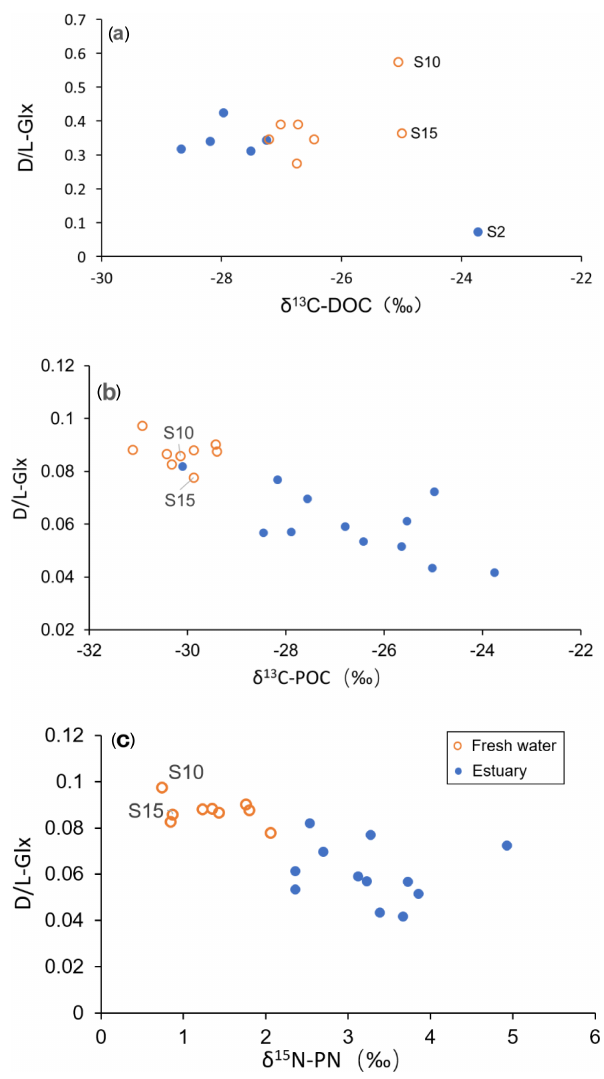
Figure 6. D / L ratio of AAs (as Glx) plotted against (a) DOC- δ 13 C (b) POC- δ 13 C, and (c) PN- δ 15